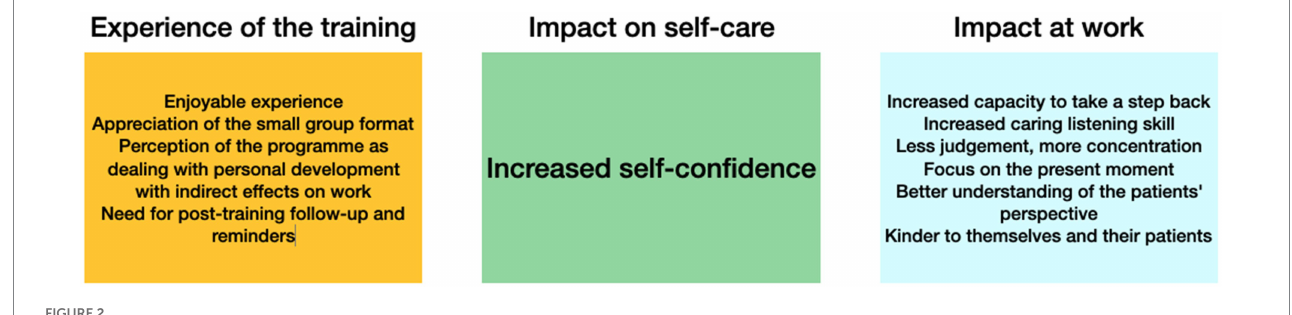
FIGURE 2 Impact of the MB Care program by domain of the interview